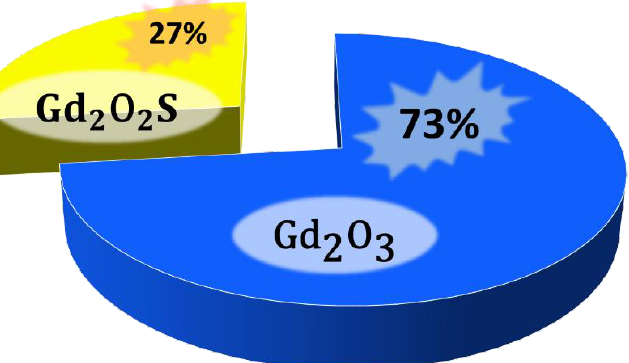
Figure 3. State of the art for gadolinium-based oxide and oxysulfide luminescent materials. Comparison of the preferential research between oxides and oxysulfides over a total of 179 publications from the last ten years.